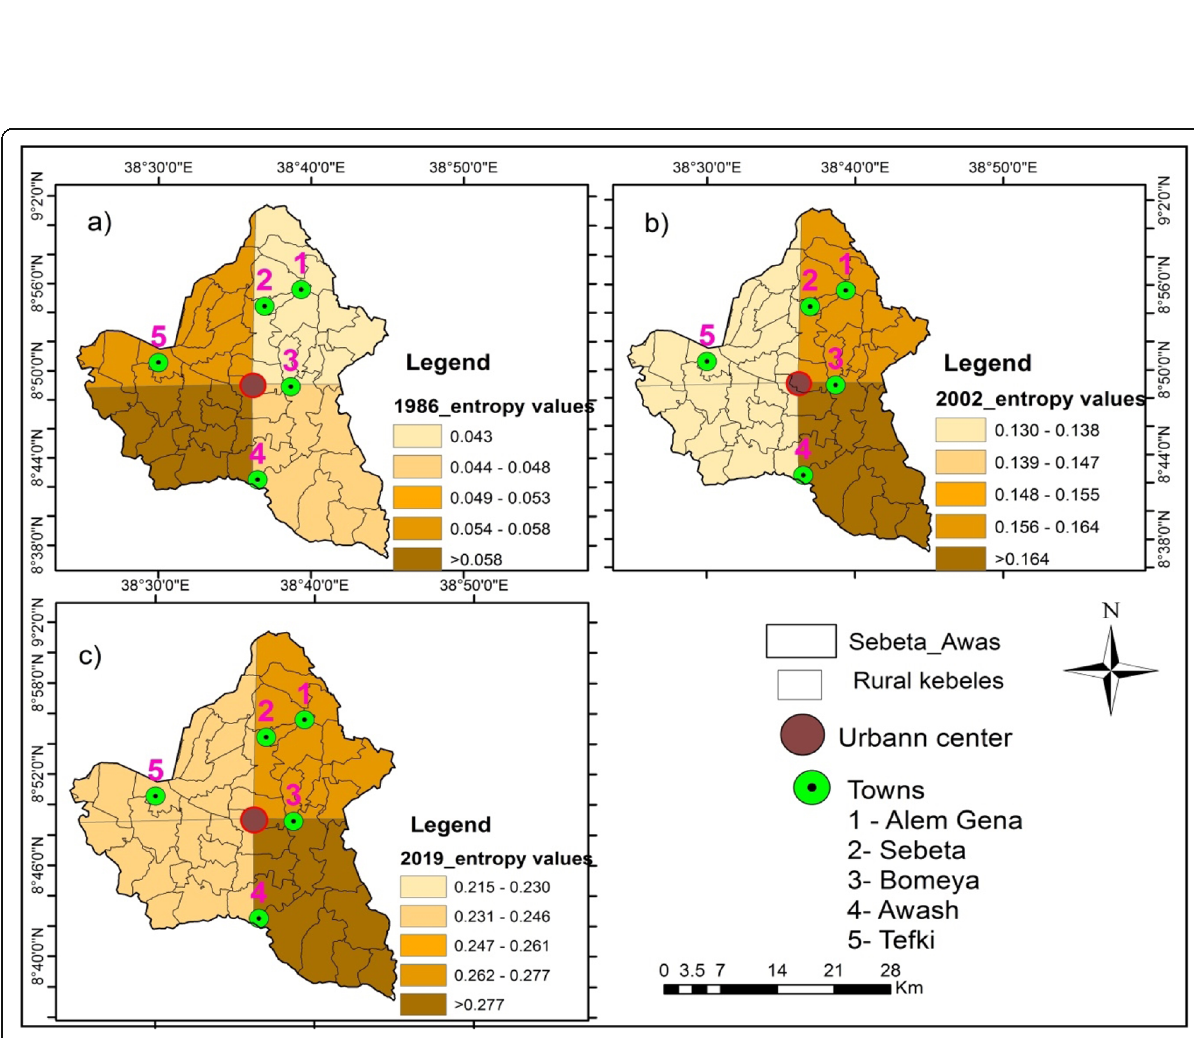
Fig. 8 Zonal entropy values a (1986), b (2002), c